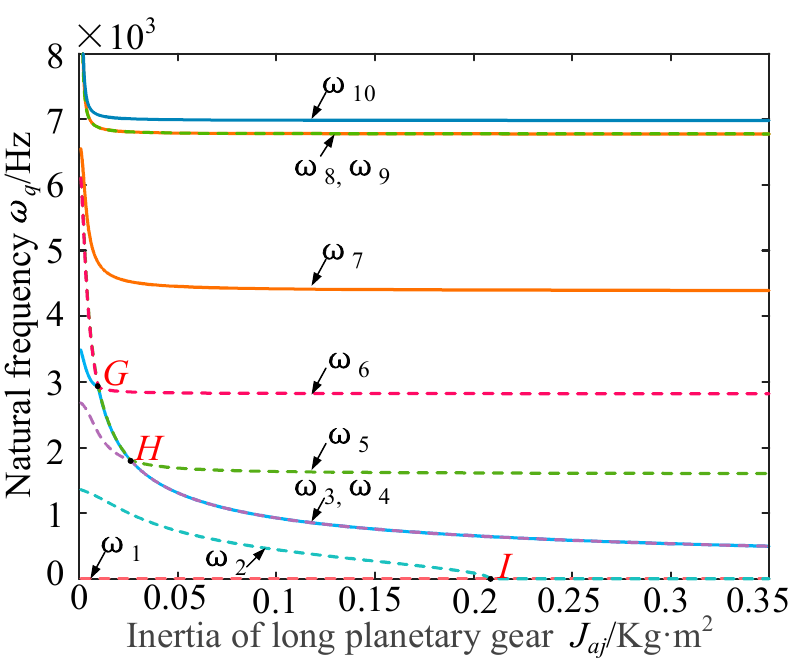
Figure 16. The trajectory of the natural frequency with J aj .